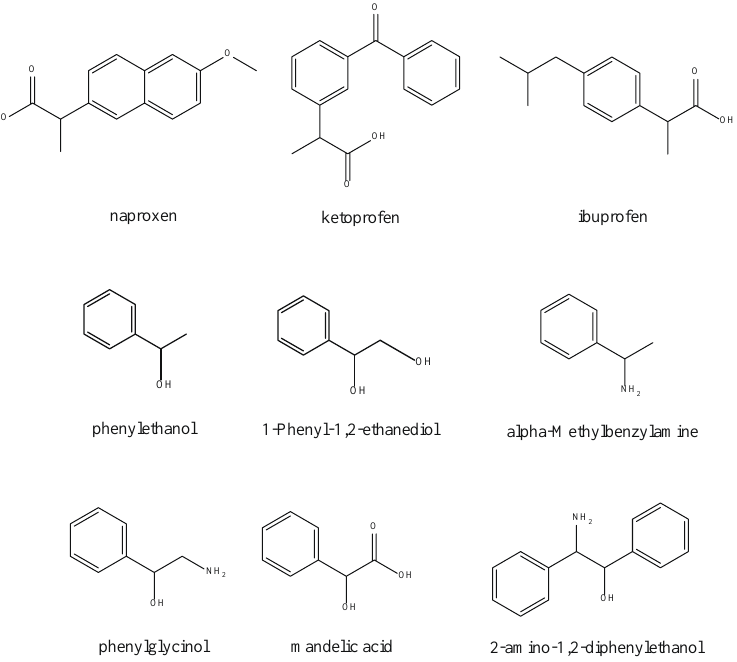
Figure 3. The structures of the selected chiral drugs and intermediates.